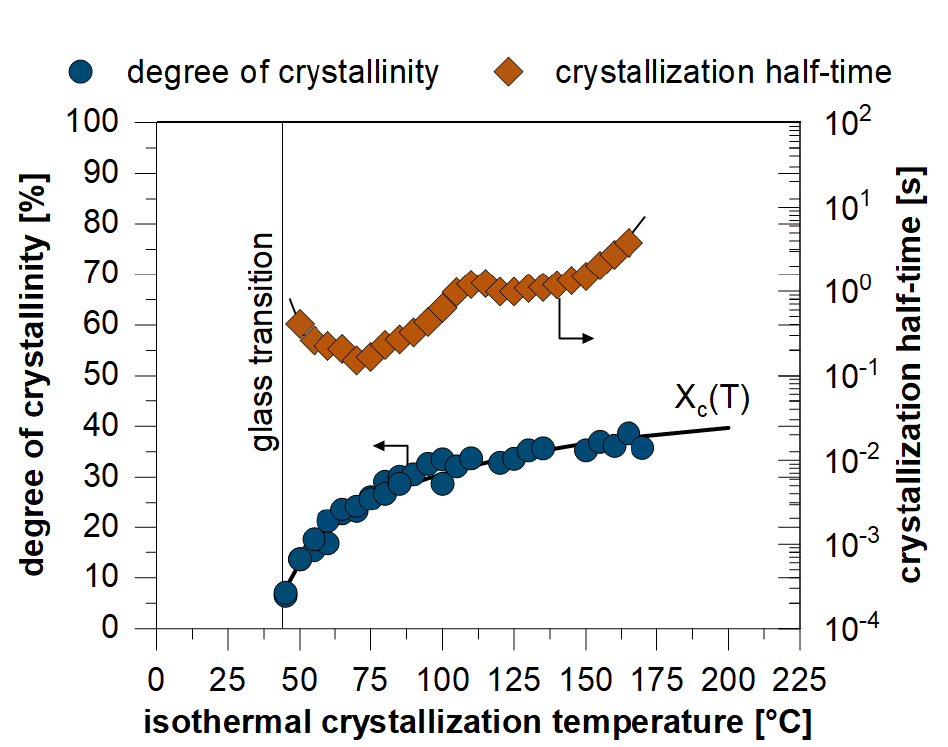
Figure 9. Dependence of the degree of crystallization on temperature for PBT, determined by